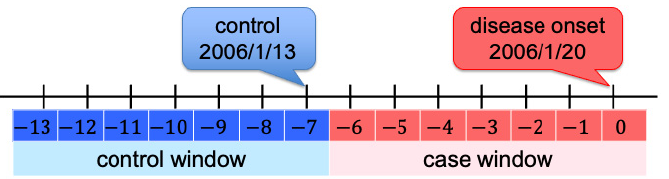
Figure 1. Illustration of selected self-matched samples based on case-crossover study design.